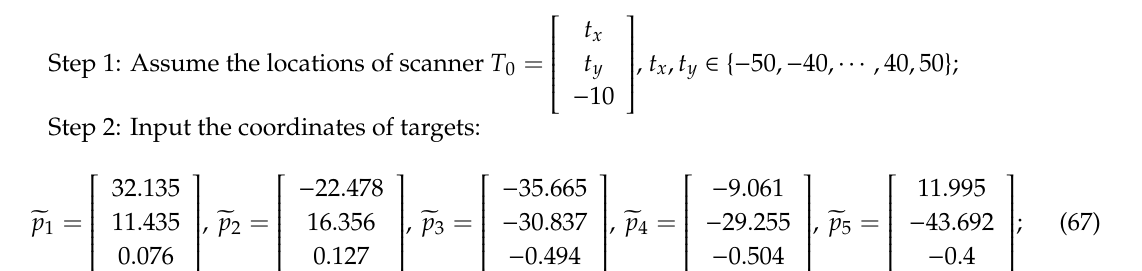
Figure 2. The target and scanner i + 1 geometry of experiment II.